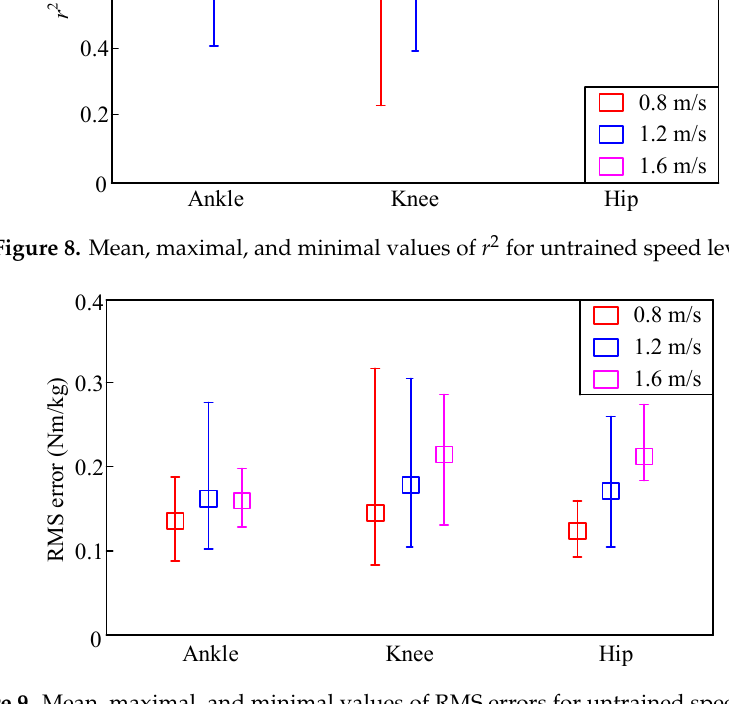
Figure 9. Mean, maximal, and minimal values of RMS errors for untrained speed levels.